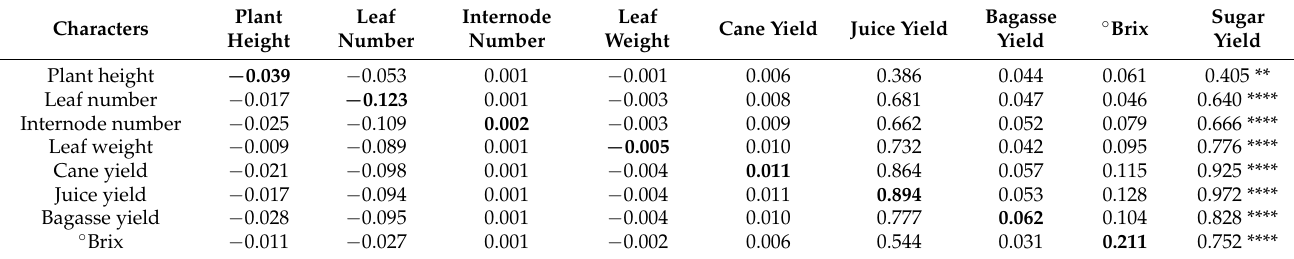
Table 4. Direct (bold diagonal) and indirect effect (off diagonal) of different quantitative characters on sugar yield of sorghum. Characters Plant